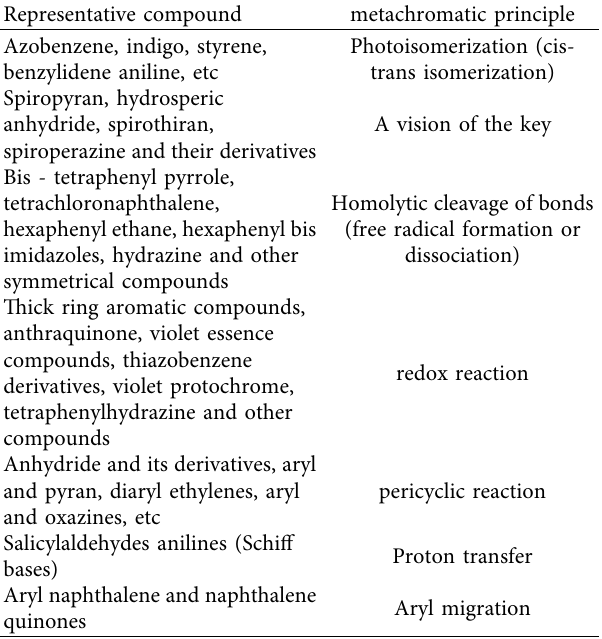
Table 5: Principle of organic